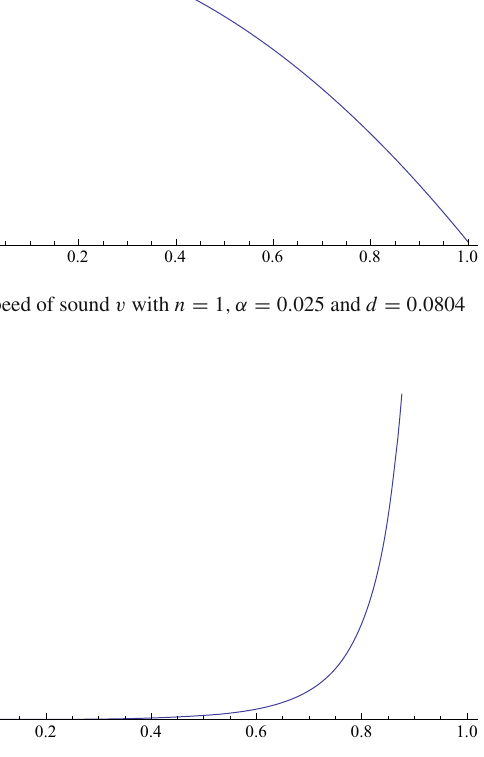
Fig. 6 tangential pressure P t with n = 1 ,α = 0 . 025 and d = 0 . 0804